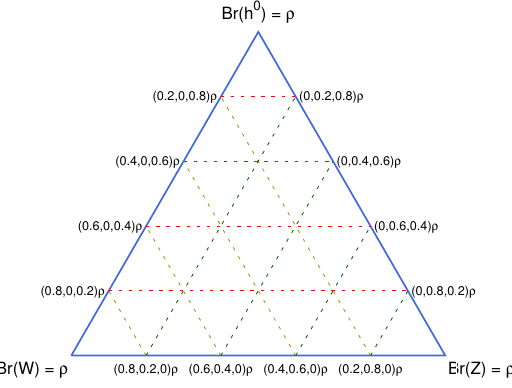
Figure 5 . Two-dimensional slice of the pyramids in (cid:12)gure 4, with 0 (cid:20) (cid:26) (cid:20) 1. Lines of constant Br( W ), Br( Z ) and Br( h 0 ) are drawn in brown, green and red,